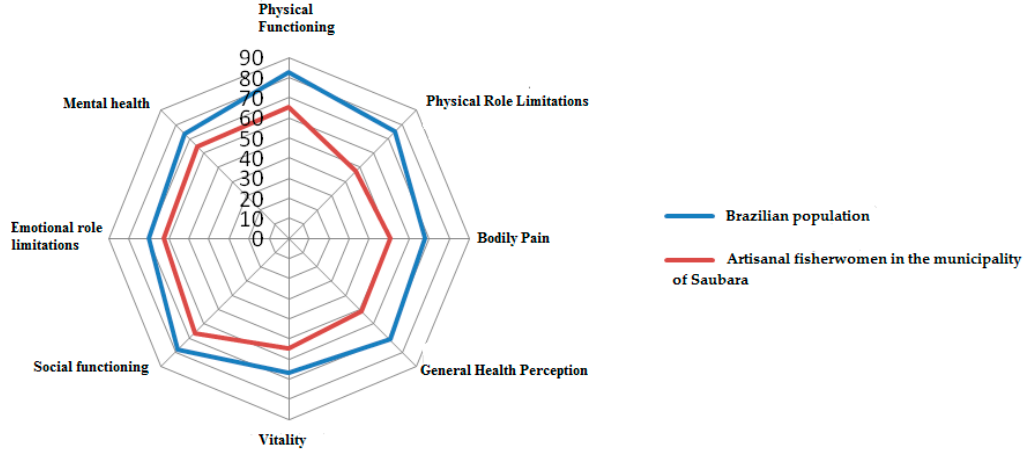
Figure 1. SF-36v01 scores from artisanal fisherwomen/shellfish gatherers from Saubara, Bahia, Brazil in relation to the Brazilian population. Source: Authors’ calculations.